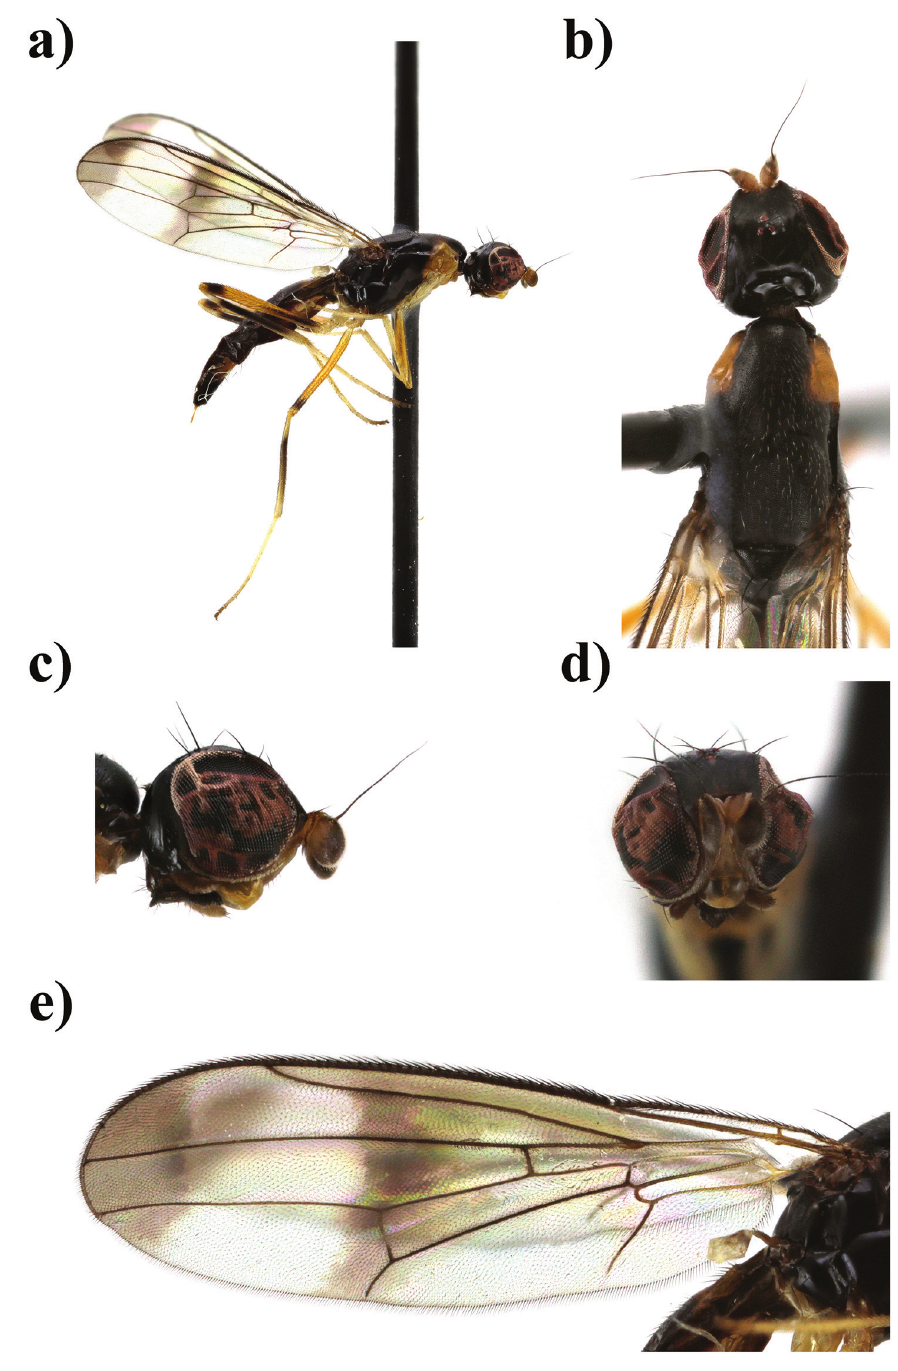
Figure 8. Strongylophthalmyia tomentosa sp. n. a habitus, lateral view b head and thorax, dorsal view c head, lateral view d head, anterior view e